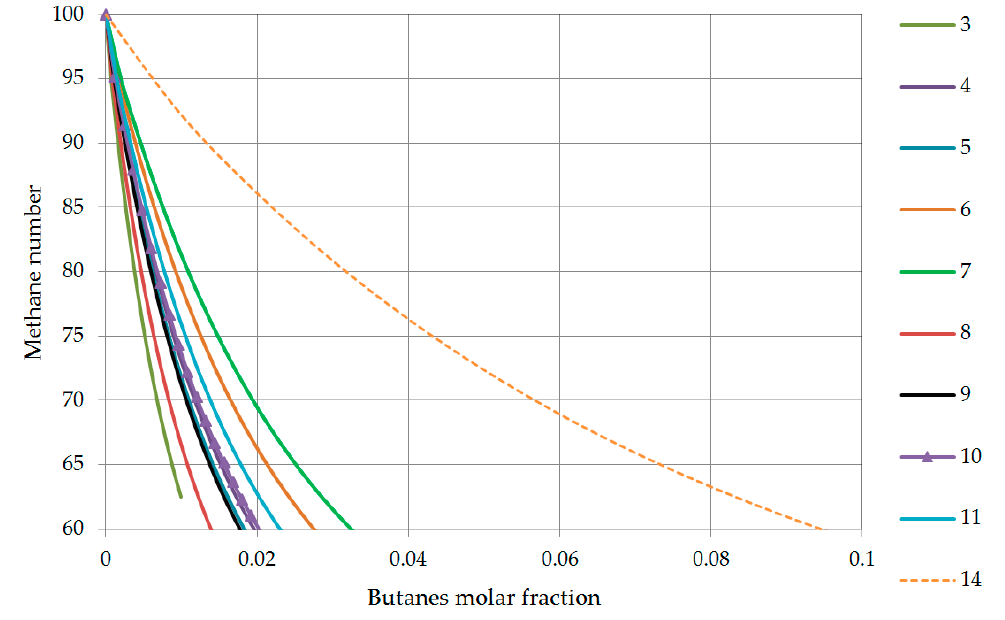
Figure 5. Methane number as function of butanes molar fraction in analyzed LNG composition sets .